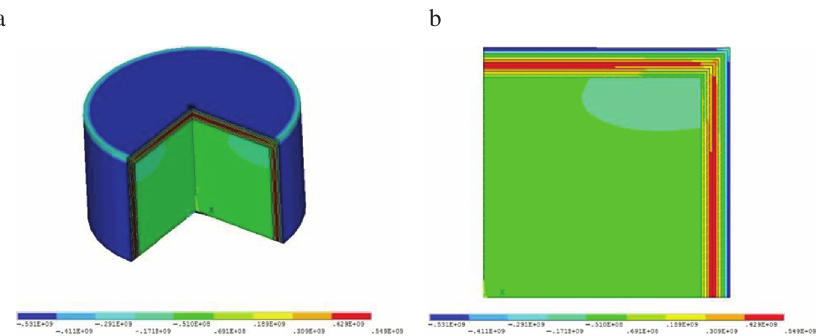
Figure 6: The residual stress nephograms of FGCC-T5 (a-sectional view, b- cross-sectional view).